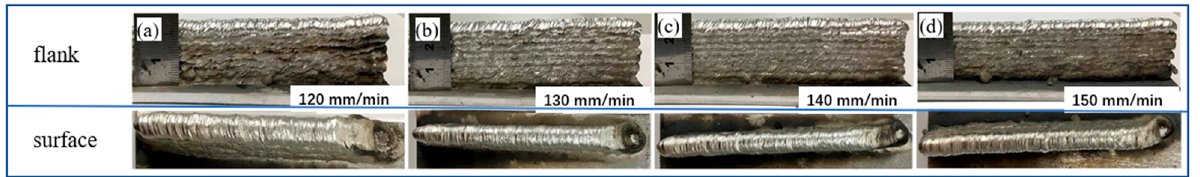
Figure 3. Forming of aluminum alloy additive manufacturing under different melting rates. ( a ) 120 mm/min, ( b ) 130 mm/min, ( c ) 140 mm/min, ( d ) 150 mm/min.